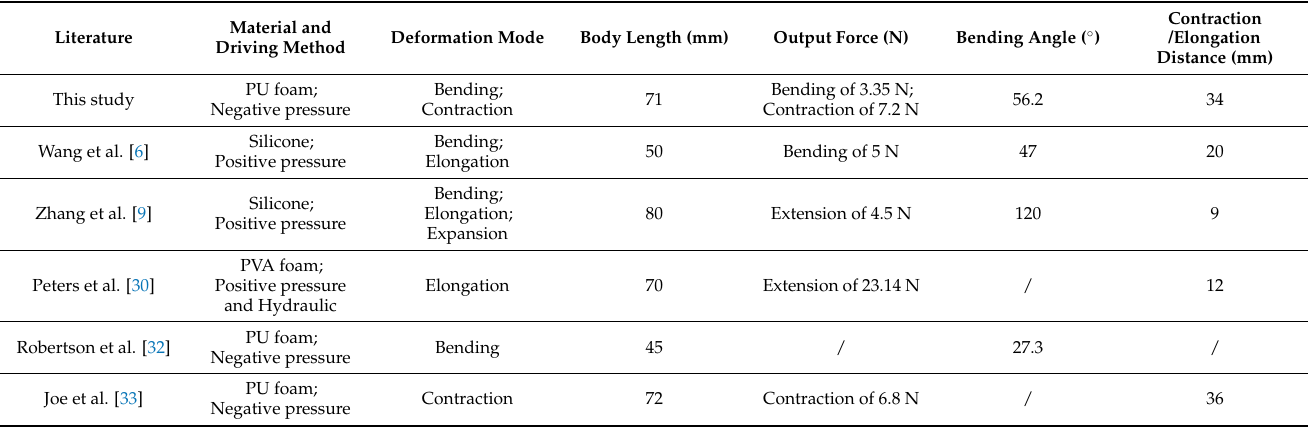
Table 3. A Comparison of Different Pneumatic Soft